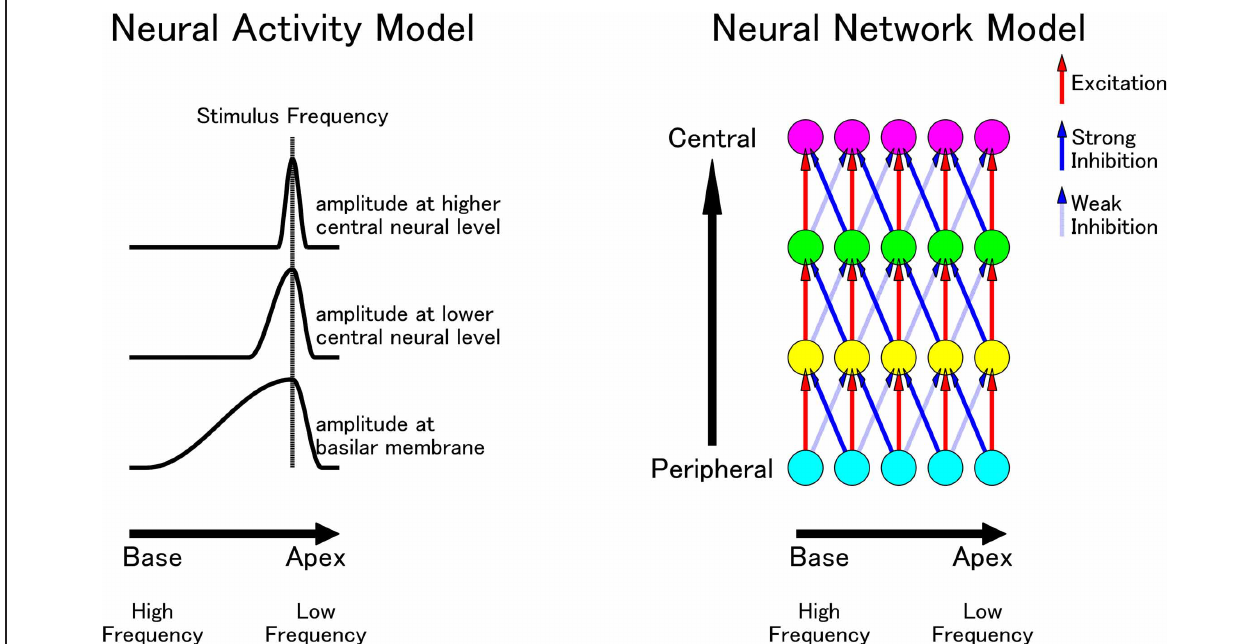
Right : a hypothetical excitatory and inhibitory neural network from the peripheral to the central auditory pathway. Red lines indicate excitatory neural connections and blue lines indicate inhibitory connections. Solid blue lines projecting from lower to higher frequencies have stronger inhibitory effects than the dashed blue lines projecting from higher to lower